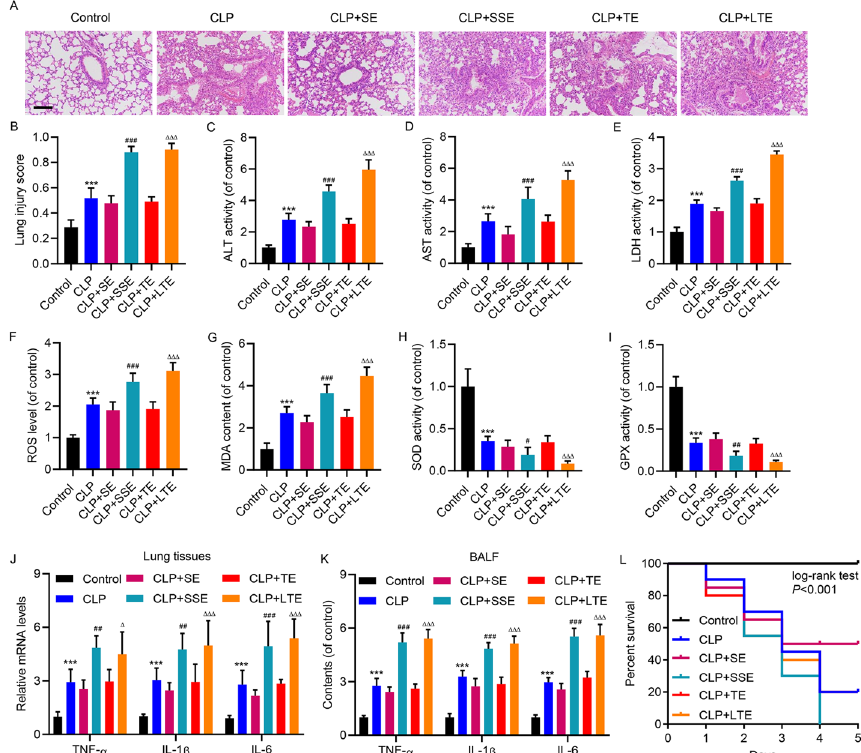
Fig. 2 Toxic effects of CD4 + T cell‑derived EVs on oxidative stress and inflammation in CLP‑induced lung injury in mice. CLP model mice were treated with EVs isolated from the serum of patients with sepsis‑induced lung injury (SSE) or of healthy subjects (SE), or CD4 + T cells isolated from healthy subjects treated with (LTE) or without (TE) 10 μg/mL LPS. A H and E staining (scale bar, 100 μm). B Severity of histological injury. Plasma levels of ( C ) ALT, ( D ) AST, ( E ) LDH, and ( F ) ROS level, G MDA content, H SOD activity, ( I ) GPX activity and ( J ) mRNA expression of TNF‑α, IL‑1β, and IL‑6 in lung tissues were measured. K The BALF content of TNF‑α, IL‑1β, and IL‑6 in mice was measured by ELISA. L The survival rate of mice was monitored within 5 days, showing shortened survival with EV treatment. Data presented as mean SD. *** P < 0.001 versus control. # P < 0.05, ± ## P < 0.01, ### P < 0.001 versus CLP SE. Δ P < 0.05, ΔΔΔ P < 0.001 versus CLP + +